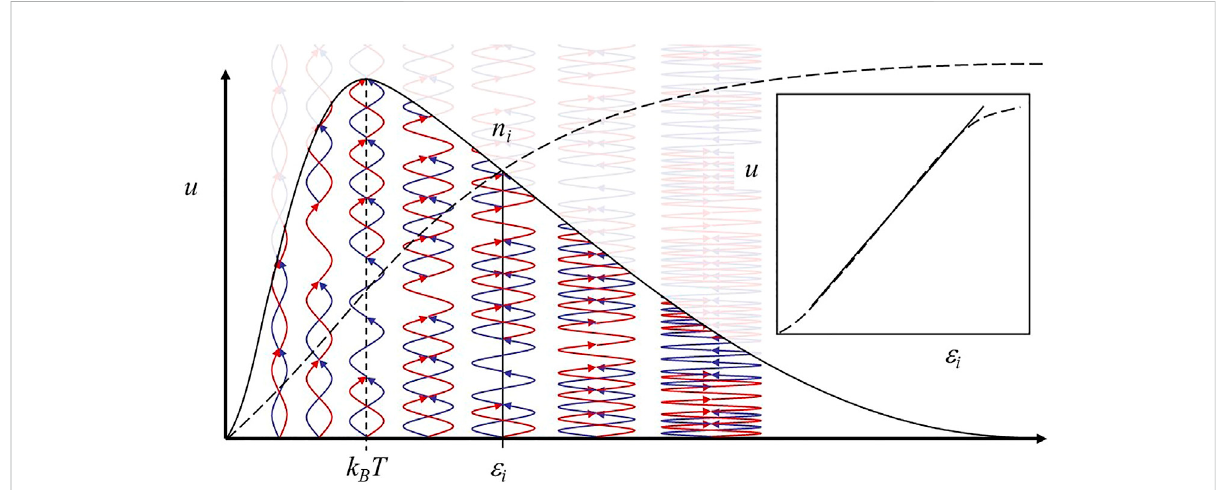
FIGURE 2 Vacuumspectraldensity, u ,sumsupfromnumerousraysofphotons(blue-redwaves)withaspectrumofenergies, ε i ,abouttheaverageenergy, k B T . The paired photons cannot be seen as light but are sensed as inertia and gravitation through their coupling to matter [63]. In contrast, the odd quanta (blue or red), distributed in-phase or antiphase among the paired rays, are seen as light and manifest as electromagnetism. Inset: The cumulative spectral density vs. energy (dashed line) mostly follows a power law, i.e., a straight line on the log – log